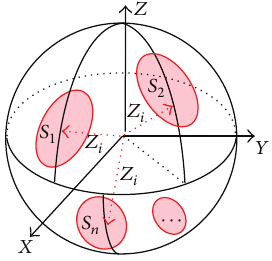
Figure 4: Reached areas to the spherical area.